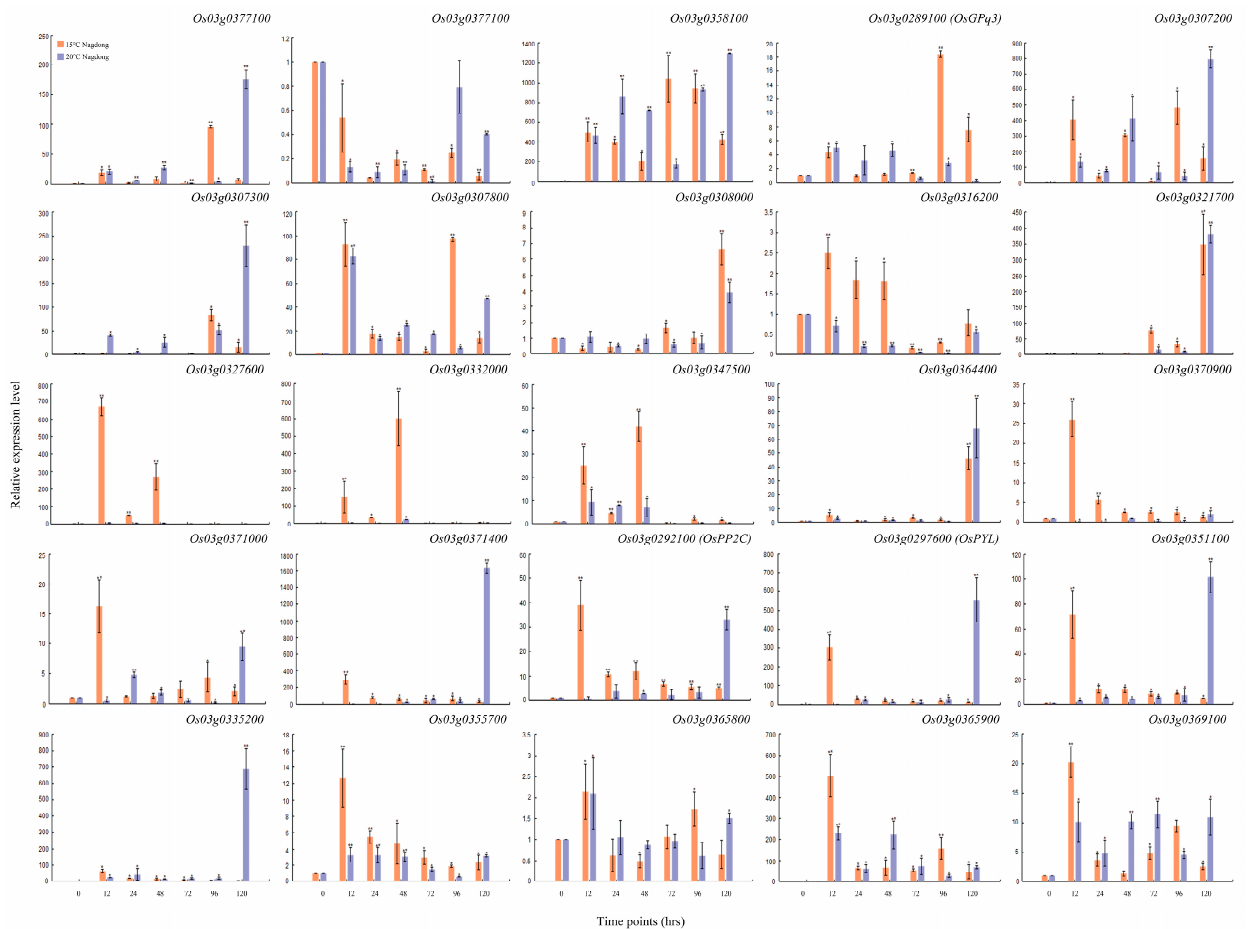
Figure 5. qRT-PCR data about the genes related to seed germination under LDT conditions in Nagdong parent. Relative expression levels were analyzed at 0, 12, 24, 48, 72, 96 and 120 h. Each time point is compared with 0 h under 15 °C and 20 °C conditions. Graph bars indicate mean ± standard deviation and asterisks show a significant difference (* p < 0.05, ** p < 0.01) analyzed by t test.